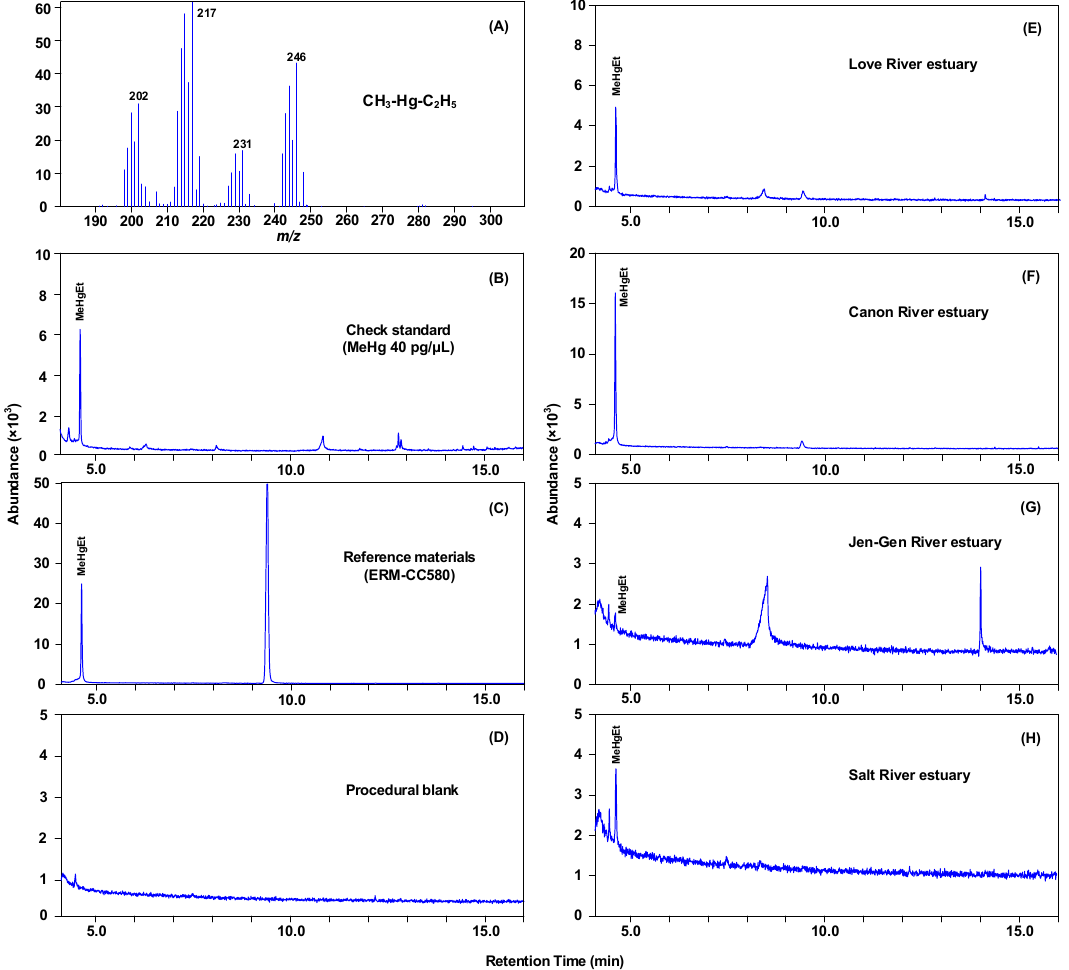
Figure 2. ( A ) The electron impact mass spectra for GCMS analysis of MeHgCl standard solution derivatizing with NaBEt4; chromatogram of the selected major ion 217 m / z for ( B ) the check standard, ( C ) reference material (ERM ‐ CC580), ( D ) procedural blank, and four estuaries of ( E ) Love River, ( F ) Canon River, ( G ) Jen ‐ Gen River, and ( H ) Salt River.